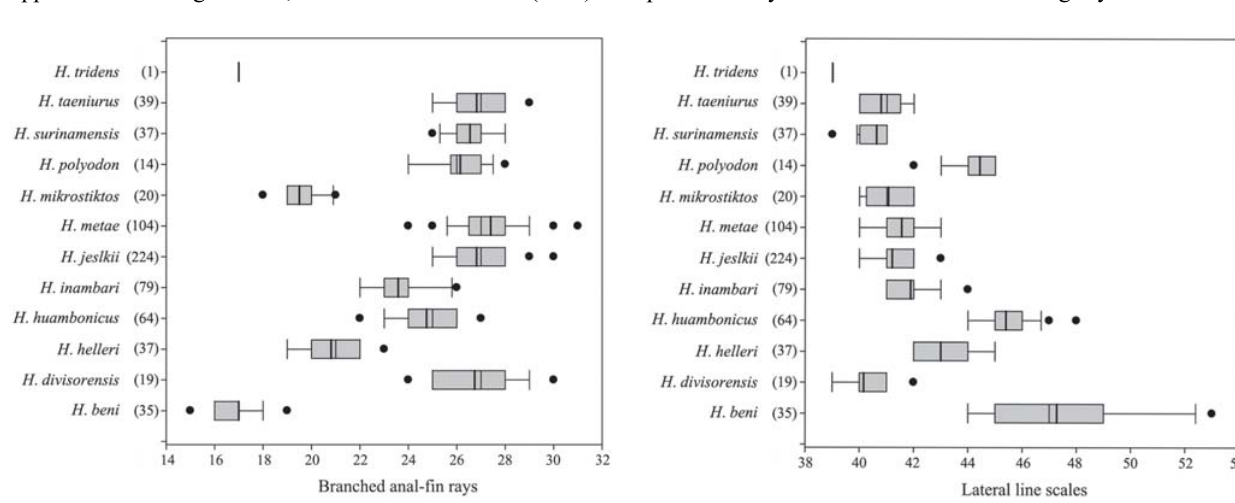
Fig. 3. Tukey box plots of number of lateral line scales in Hemibrycon species. Mean represented by thick vertical bar, and 25 th and 75 th percetiles as lateral borders of box plots. Number in parentheses =